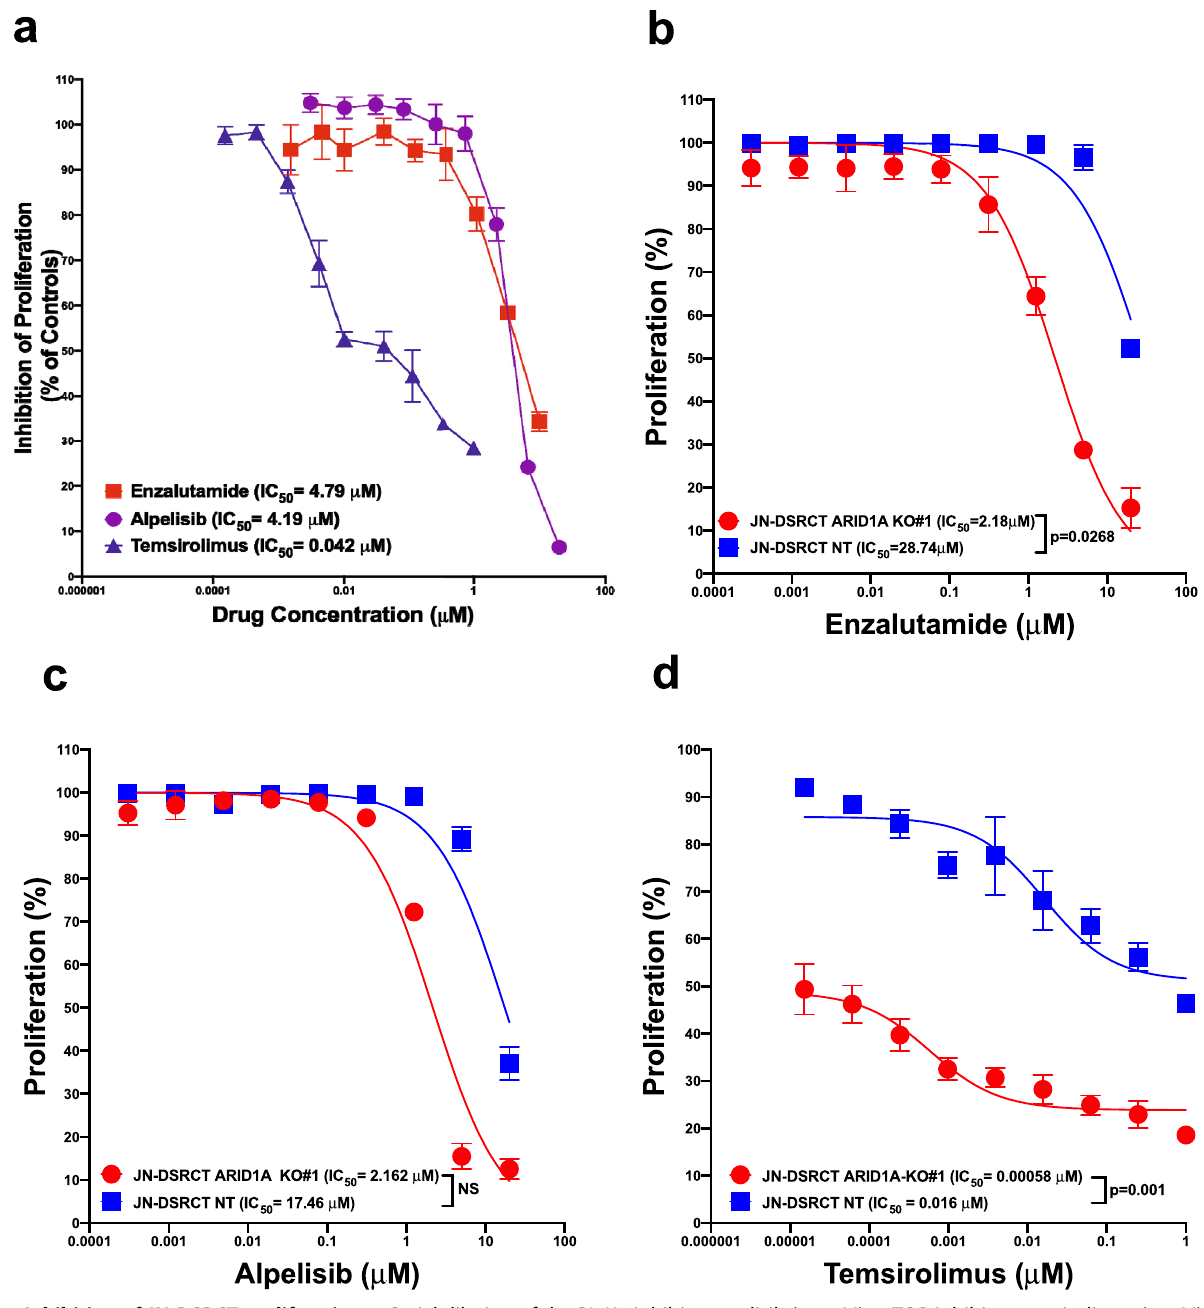
Fig. 7 Inhibition of JN-DSRCT proliferation. a Serial dilution of the PI3K α inhibitor apelisib (20 mM), mTOR inhibitor temsirolimus (1 mM), and AR inhibitor enzalutamide (20 mM) were given in triplicate and imaged every four hours for 5 days (enzalutamide and alpelisib) and 9 days (temsirolimus). This graph was based on cell mean a percentage of untreated cells (control DMSO) corresponding to the percentage inhibition of proliferation on the last day of imaging. b – d Knockout of ARID1A in JN-DSRCT using the sgRNAs (KO#1) enhances sensitivity to enzalutamide ( b ), alpelisib ( c ), and temsirolimus ( d ) as measured by a cell-based proliferation assay in a time-dependent manner using Incucyte. NT = parental control. The error bars in the plots represents standard deviation. The IC50 values corresponding to the NT cells in all the assays vary widely because of their different endpoint times: ( b ) (240 h), ( b , c ) (192 h), and ( d ) (144 h). It might also be due to the noise, and mainly, these proliferation assays had been run for an extended time (6 – 10 and SCNAs occurred within the trunks of the phylogenetic trees. DSRCT is often diagnosed at a late stage, after tumors have No recurrently mutated genes other than the EWSR1-WT1 fusion already become large and spread to other parts of the body, occurred within the trunks. This suggests that all of the masses mainly in the abdomen. To clarify whether multiple masses arose from individual patients were closely related, with homogeneous independently or have a shared origin, we constructed mutation mutation pro fi les and likely developed from a single lesion where and SCNA phylogenetic analysis for four patients for whom multi- the EWSR1-WT1 fusion was the main driver of tumor initiation. site sampling were available. We observed that all samples had This is consistent with the general belief that fusion-positive identical EWSR1-WT1 fusion breakpoints and that most mutations